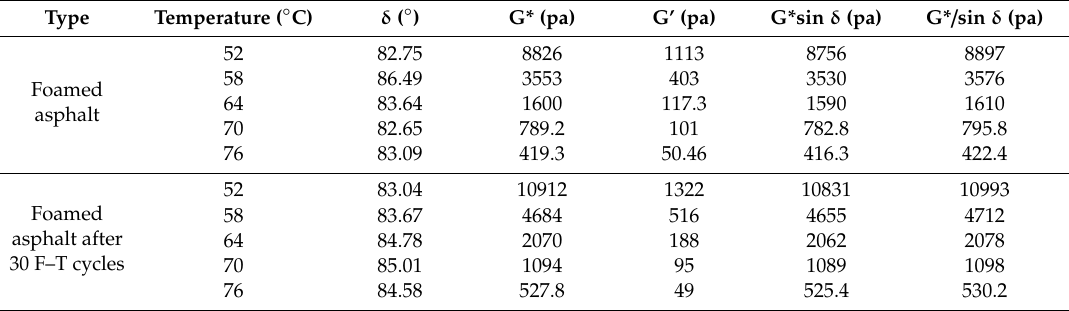
Table 6. Temperature sweep test results of foamed asphalt and foamed asphalt with 30 F–T